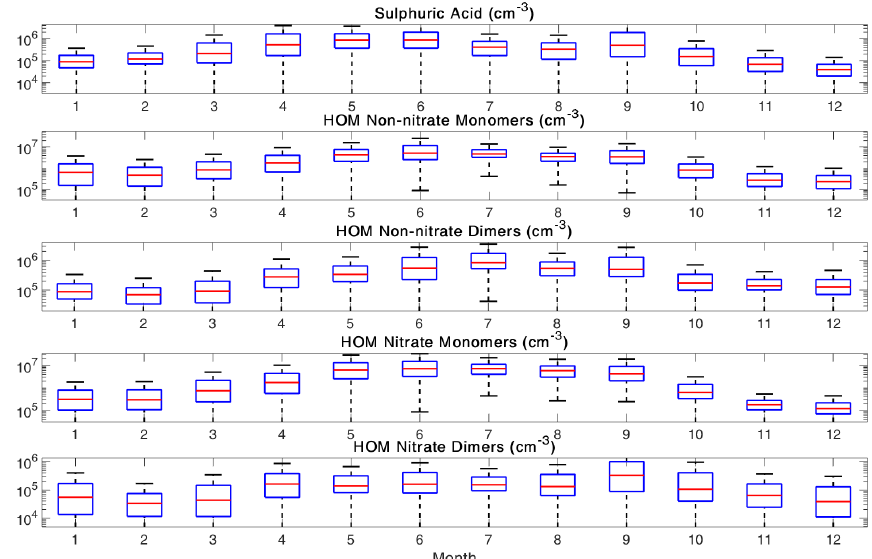
Figure 9. The annual variation of the analyzed precursor vapors. The red line shows the median concentration for each month, and the blue box contains 50% (25th to 75th percentile) of all data points. The whiskers mark the location of the 95th and 5th percentile data points.